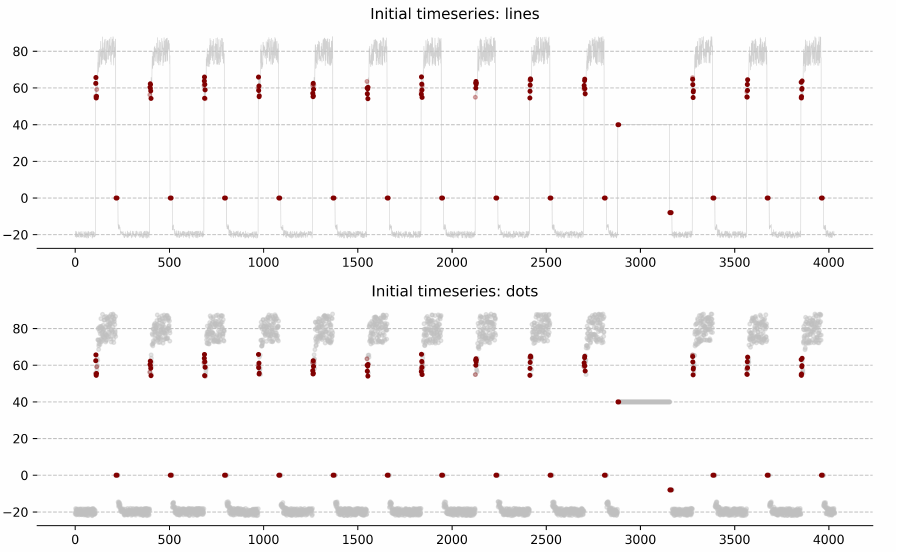
Figure 21. Numenta Anomaly Benchmark time series with anomalies in a seasonal